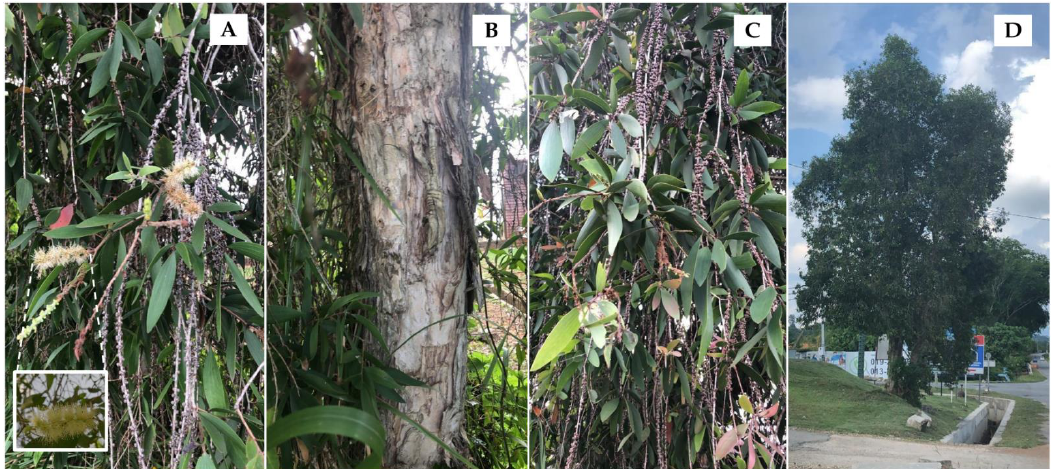
Figure A1. Malaysian Gelam tree ( Melaleuca sp.) ( A ) flower stem; ( B ) bark; ( C ) seeds and ( D ) mature tree in an urban area. Images generously donated by Professor Dr. Mohd Nazip Suratman [46].